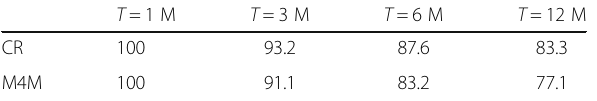
Table 3 Surface areas changes of access-hole filling. Unit: %